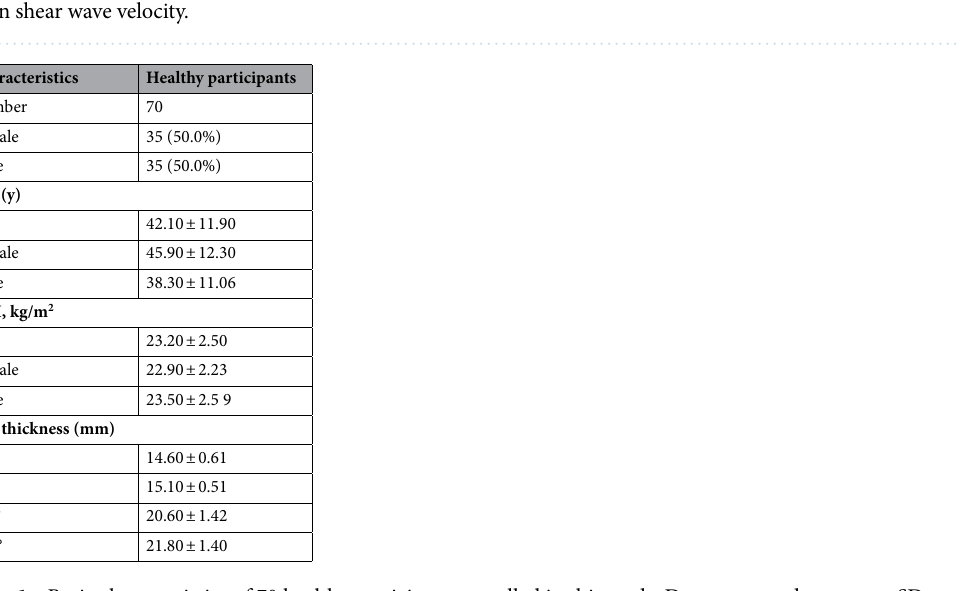
Table 1. Basic characteristics of 70 healthy participants enrolled in this study. Data presented as mean ± SD and number (percent) where applicable. MD middle deltoid, mm millimeter, SD Standard deviation, BMI